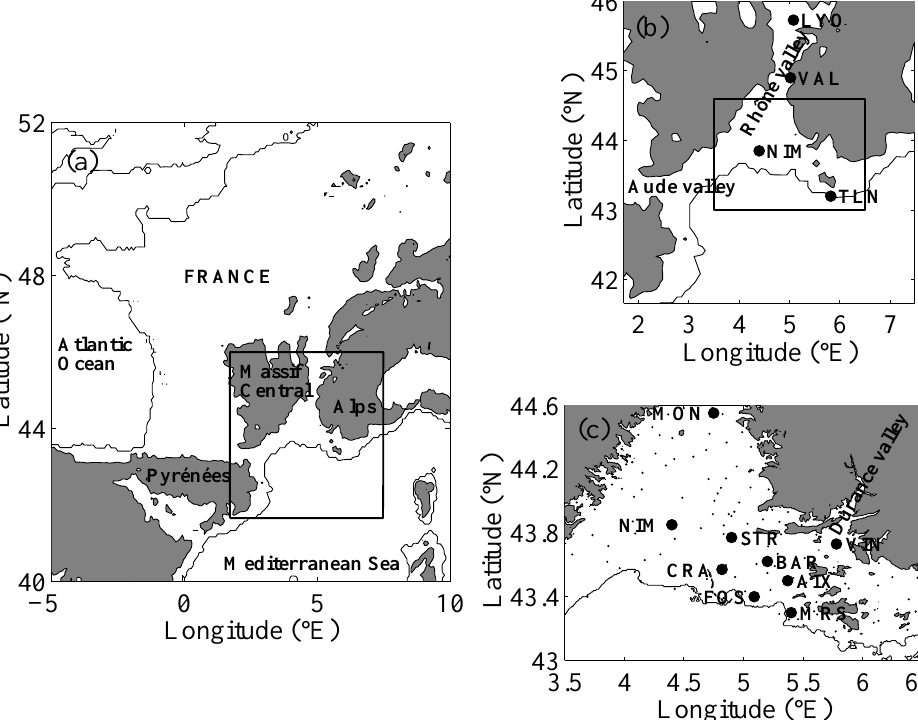
Fig. 1. Panel (a) : Map of France with the topography shaded in grey when higher than 500m above sea level. The rectangle displays the region shown in panel b. Panel (b) : Zoom corresponding to the region shown by a rectangle in panel (a). The acronyms NIM, LYO, TLN and VAL indicate the cities of Nˆımes, Lyon, Toulon and Valence, respectively. Panel c: Zoom corresponding to the region shown by a rectangle in panel (b). The dots indicate the locations of the operational meteorological surface stations operated by M´et´eo-France. The acronyms AIX, BAR, CRA, FOS, MON, MRS, STR and VIN indicate the cities of Aix en Provence, Barben, la Crau, Fos-Berre, Mont´elimar, Marseille, Saint R´emy de Provence and Vinon, respectively.